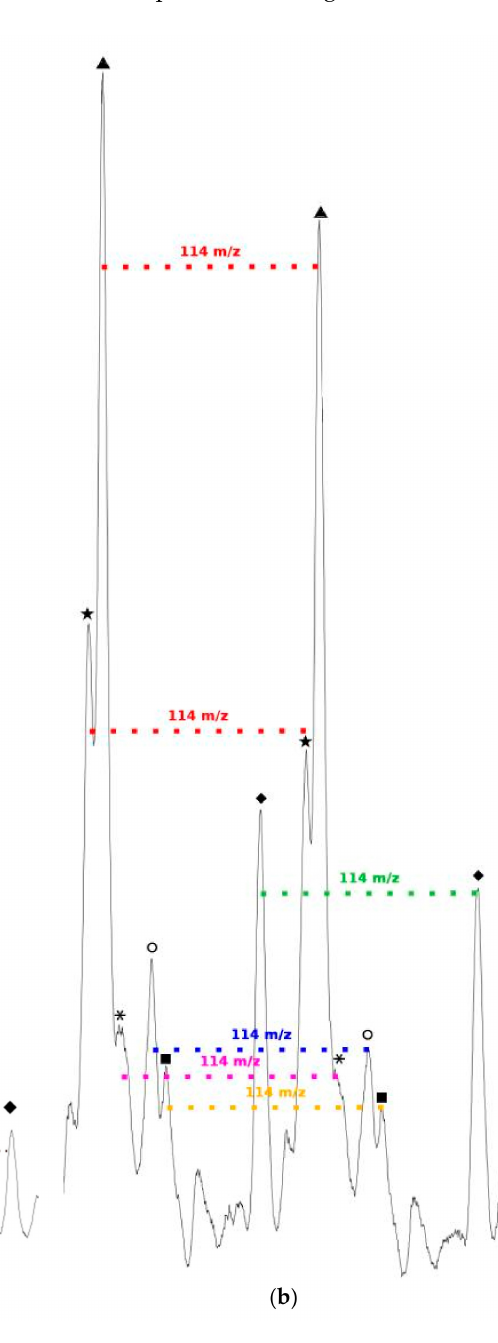
Figure 7. Interval between the successive peaks of a same polymer chain distribution for the polymerization of CL with: ( a ) 2 mol %; and ( b ) 10 mol % of N -Boc Cys